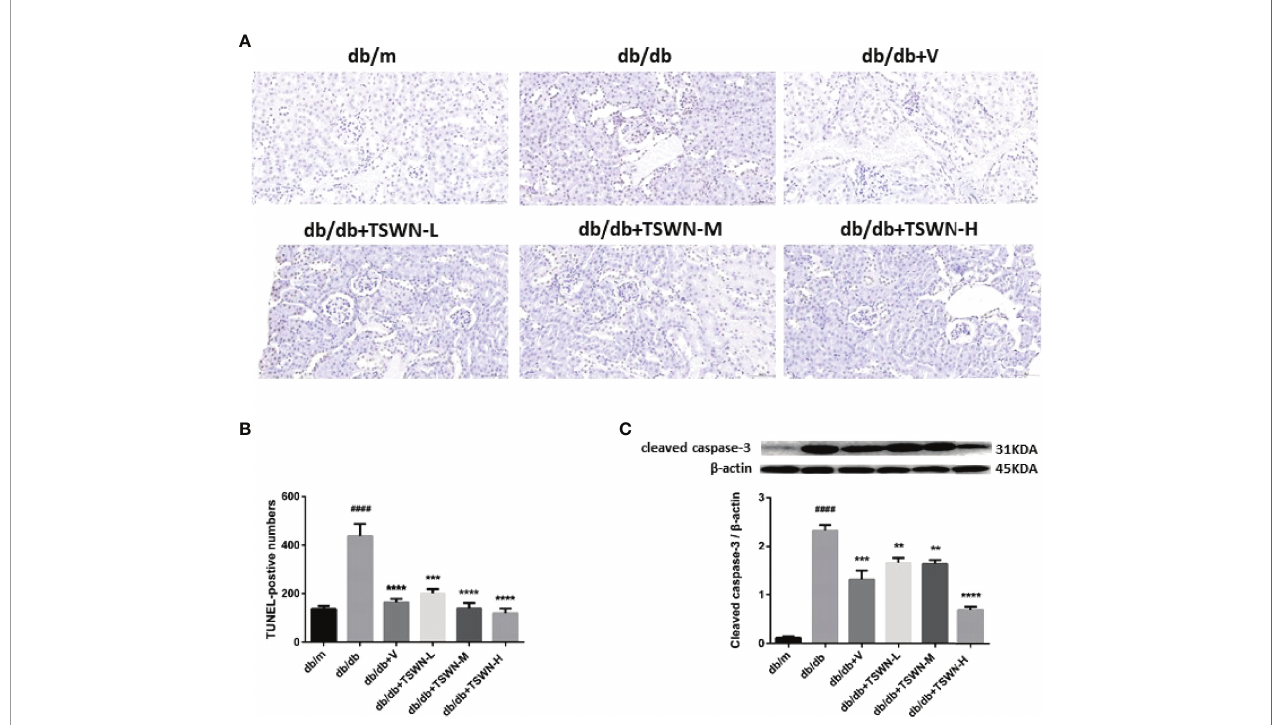
FIGURE 5 | Apoptosis in mouse kidneys. (A, B) Representative photographs and quanti fi cation of renal apoptosis measured by TUNEL assay. (C) Representative photographs and quanti fi cation of cleaved caspase-3 in mouse kidneys detected by western blot. n = 6 mice/group. #### P < 0.0001 vs db/m group; **P < 0.01, ***P < 0.001, ****P < 0.0001 vs db/db group. Db/m, db/m mice; db/db, db/db mice; db/db+V, db/db mice with valsartan treatment; db/db+TSWN-L, db/db mice with low dose TSWN treatment; db/db+TSWN-M, db/db mice with middle dose TSWN treatment; db/db+TSWN-H, db/db mice with high dose TSWN treatment. Data are means ±